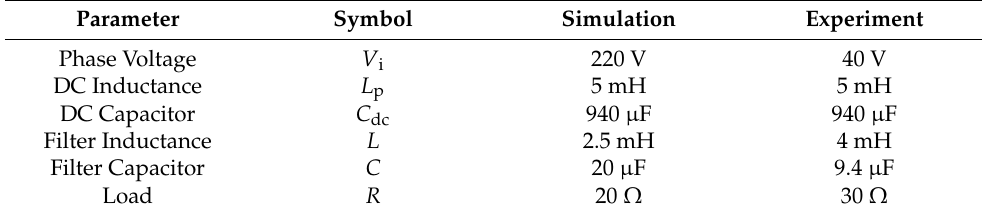
Figure 9. Experimental system of a three-phase current source converter.